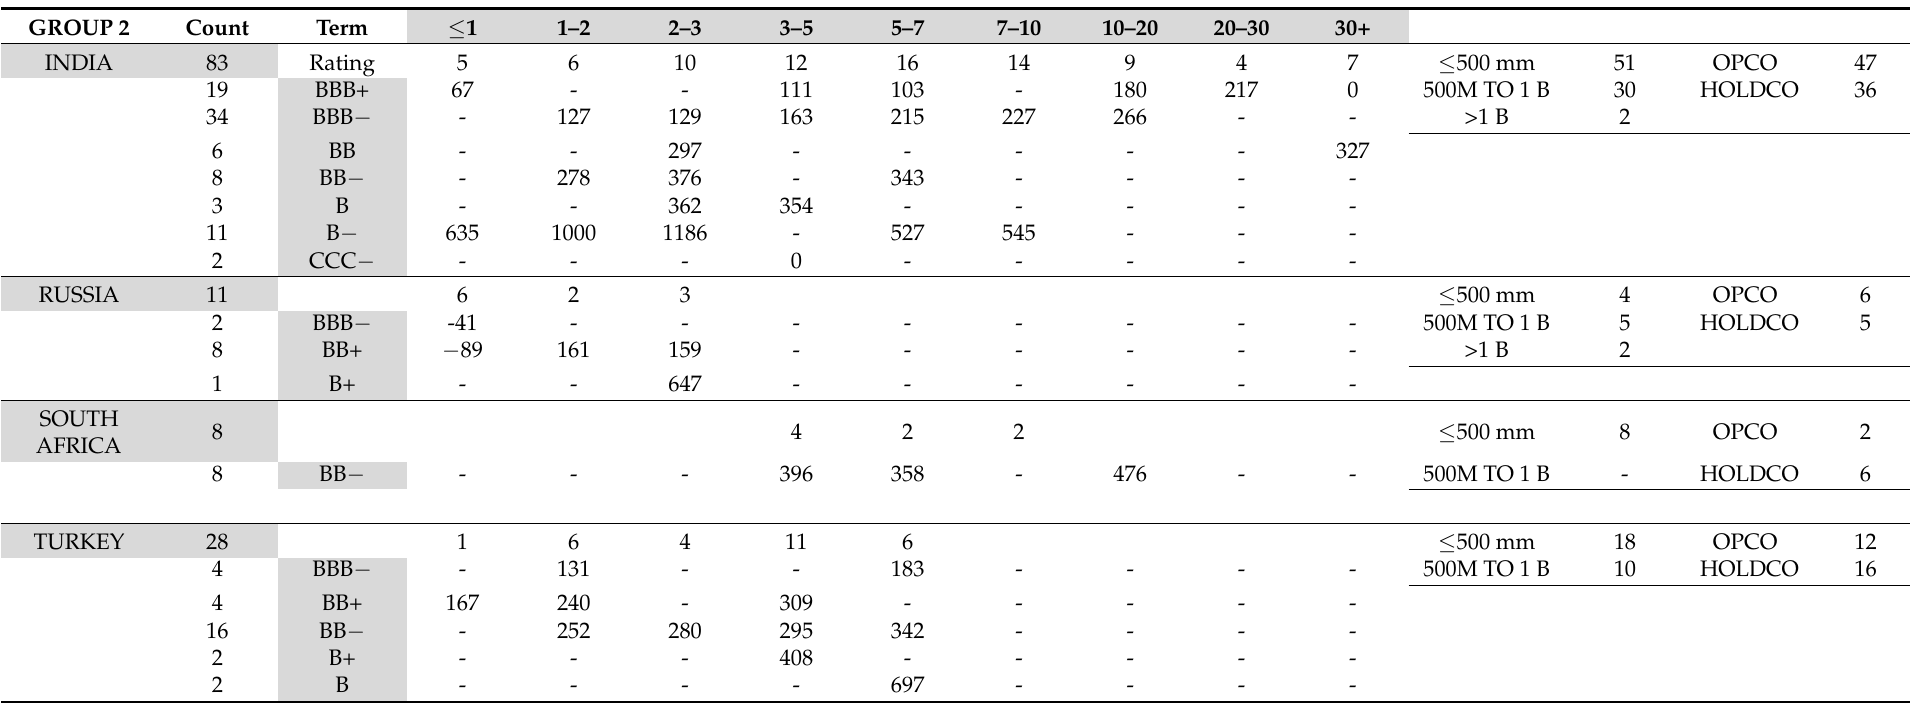
Table 4. G20—Group 2—Corporate credit spreads with S&P ratings and terms to maturity, issue amount, and the business structure of the issuer. Adding